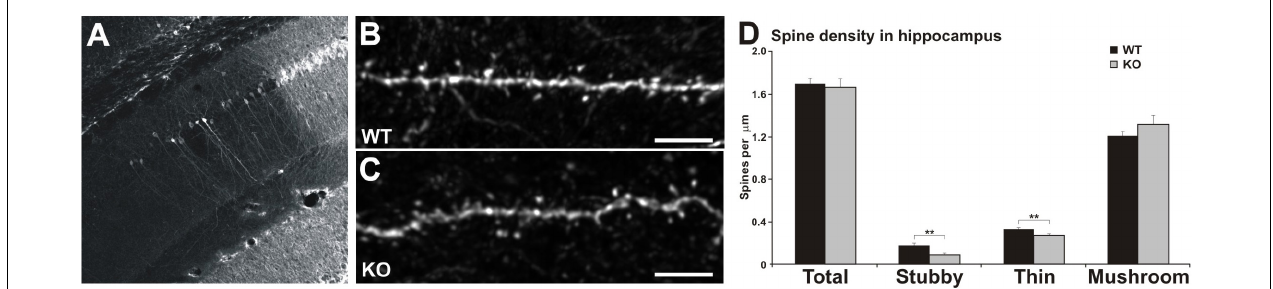
FIGURE 4 | Reduced number of thin and stubby spines in the hippocampus of MIM KO mice. (A) Representative picture of lentiviral transfection in the CA1 area of the hippocampus. (B,C) Dendrites of CA1 pyramidal hippocampal neurons expressing GFP for dendritic spine analysis. Scale bars: 5 µ m. (D) Quantification of spine morphology reveals a decreased number of stubby and thin spines without altering the total spine density. Spine density of thin, mushroom, and stubby spine morphologies: WT = 0.33 thin, 1.20 mushroom, 0.17 stubby, total density 1.70 spines/ µ m; MIM KO = 0.27 thin, 1.31 mushroom, 0.08 stubby, total density 1.66 spines/ µ m. Data represent n = 9 (WT) animals, 39.88 ± 1.08 µ m of dendrite per animal; n = 9 (MIM KO) animals, 32.35 ± 1.51 µ m of dendrite per animal. ∗ denotes statistical significance: ∗∗ p <